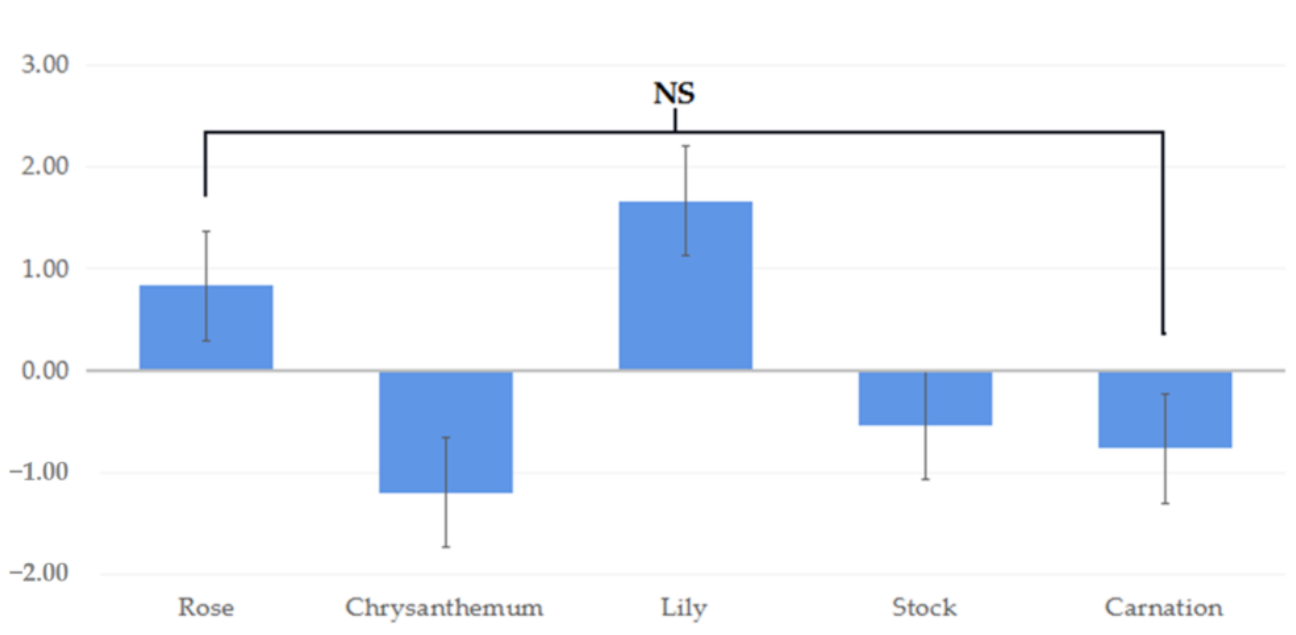
Figure 4. The results of semantic differential method (SDM) evaluation when performing five activities (** is p < 0.01, a > b, NS = no significant difference).